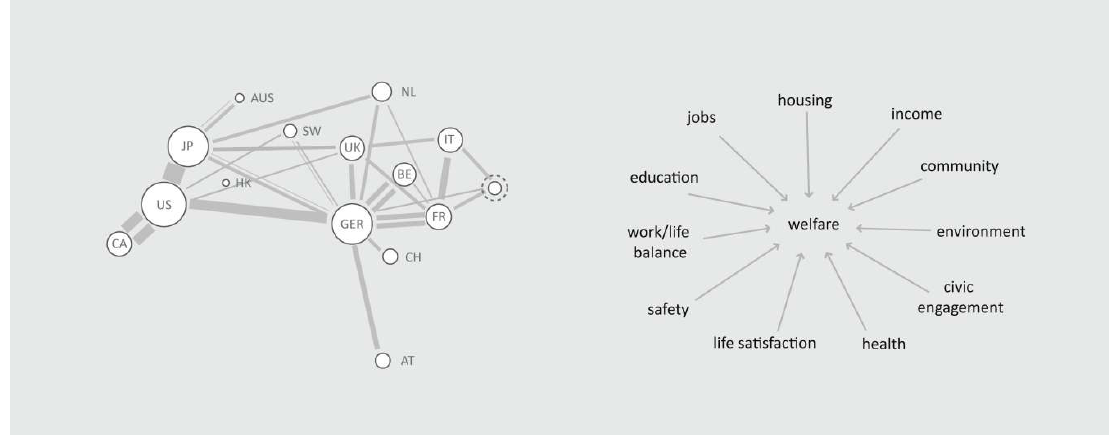
Figure 4: Examples of a social network graph visualizing flows of international trade (left) and a semantic network graph (cause-effect-diagram) displaying the relational concept of “welfare”